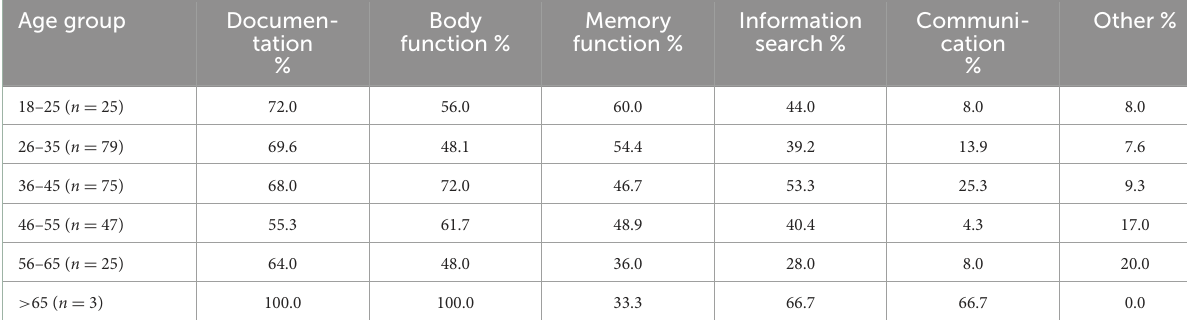
TABLE 2 App functions used by age.